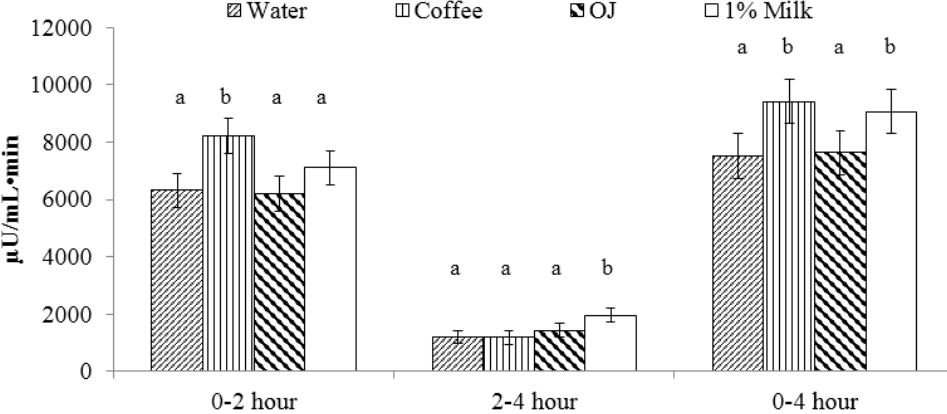
Figure 3. Postprandial plasma insulin responses to breakfast meals consumed with test beverages. ( A ) Changes in insulin concentrations during meal glucose tolerance tests; ( B ) Insulin incremental areas under the curve. a,b Bars with different letters (during the same time frame) were significantly different, p < 0.05.